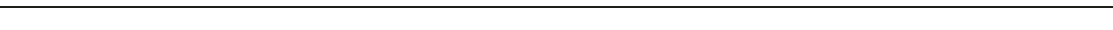
Fig. 1 The crystal structure of the MOB1/NDR2 complex reveals phosphorylation-independent interactions of MOB1 with NDR2 through conserved interfaces. a Overall crystal structure of the complex between human MOB1A (residues 33 – 216) and human NDR2 (residues 25 – 88). MOB1 and NDR2 are colored in magenta and green , respectively. The Zinc associated with MOB1 is indicated in gray . Secondary structure elements are highlighted. b The negatively charged surface of MOB1 recognizes positively charged residues on NDR2. The electrostatic surface potential of MOB1 is shown ( red : negatively charged residues; blue : positively charged residues). NDR2 is shown as a ribbon representation colored in green . c The MOB1/NDR2 binding surfaces are highly conserved. The residues of MOB1 are gradually colored according to conservation scores ( dark red : most conserved residues; dark cyan : least conserved residues). NDR2 is shown as a ribbon representation colored in green . d Structure based sequence alignment of MOB1 from indicated species. MOB1 residues mediating interactions with NDR2 are marked with brown (main-chain hydrogen bonds), green (side-chain hydrogen bonds), and magenta circles (van der Waals interactions). α helices are painted with cyan background. Thr12 and Thr35 phosphorylation sites are indicated by red arrows . e , f The interaction interfaces of MOB1 with the α 1 (residues 25 – 56) and α 2 (residues 61 – 84) helices of NDR2. MOB1 and NDR2 and their key interacting residues are shown in pink and green , respectively. Dashed lines represent hydrogen bonds. Side-chain nitrogen, oxygen, and sulfur atoms of MOB1 and NDR2 residues are colored in blue , red and gold , respectively. The hydrogen bond network connecting the α 1 and α 2 helices of NDR2 is also illustrated in f . For a stereo image of a portion of the electron density map see Supplementary Fig. 18